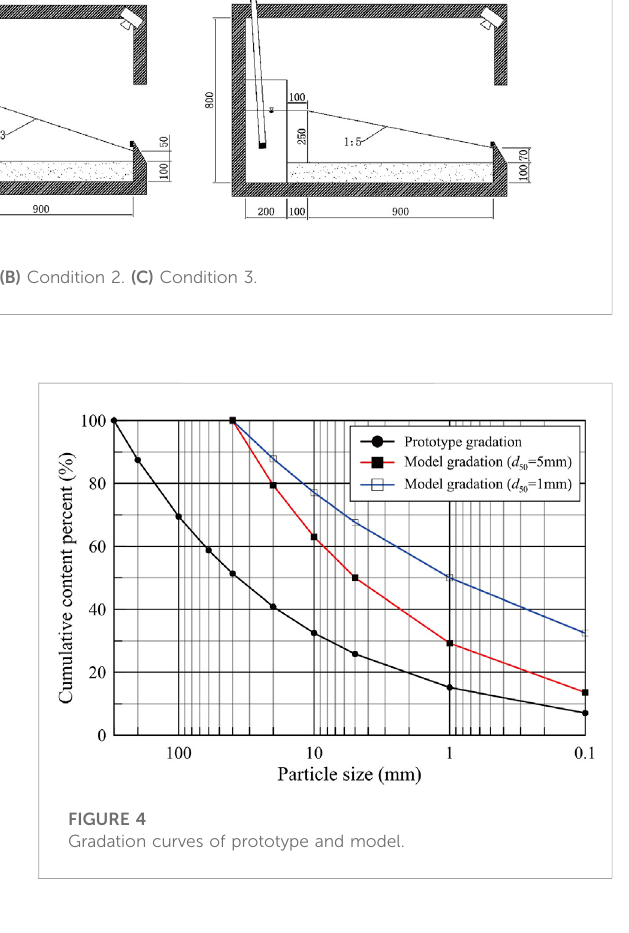
TABLE 3 Parameter settings of the three in fl uencing factors for the four